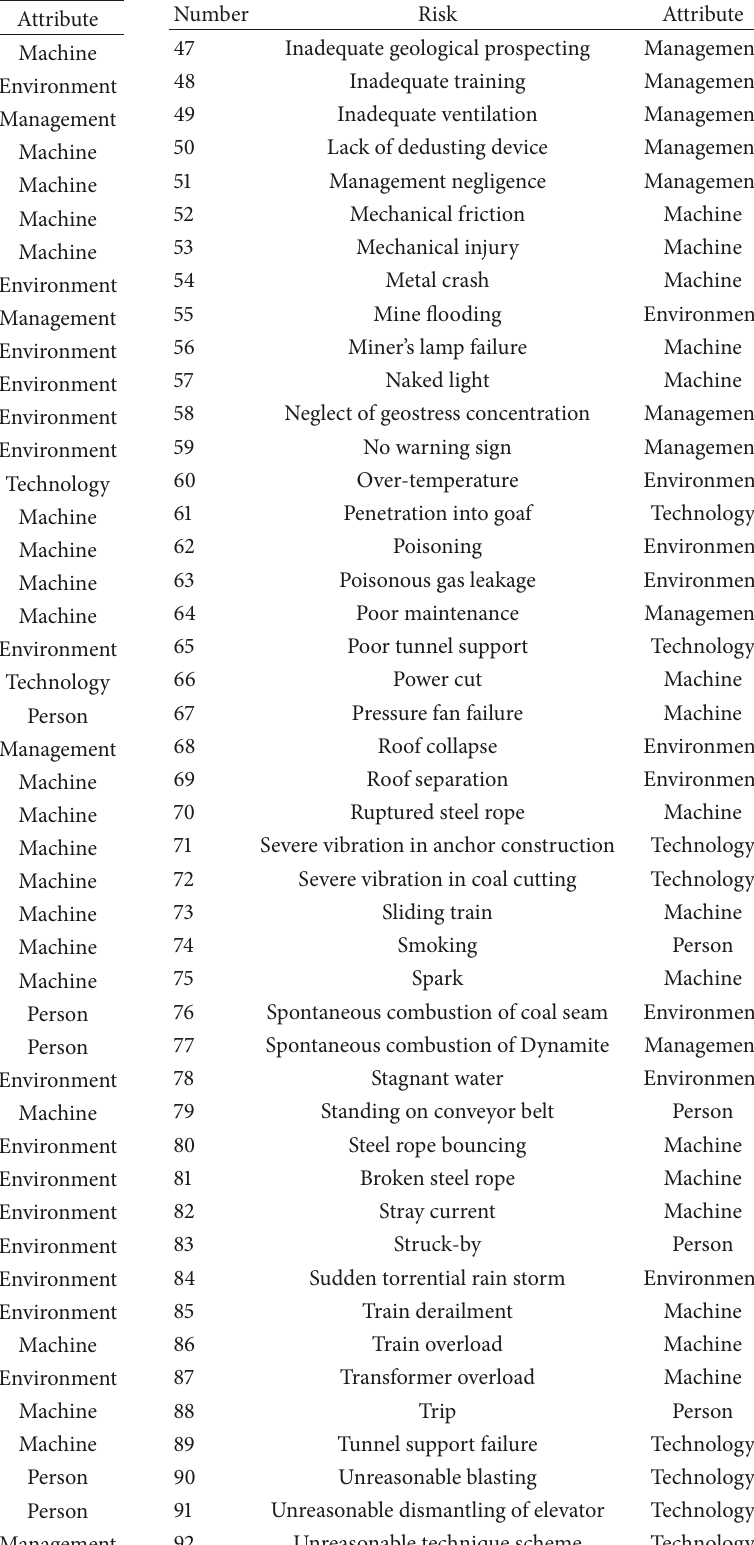
Table 4: Risk number and